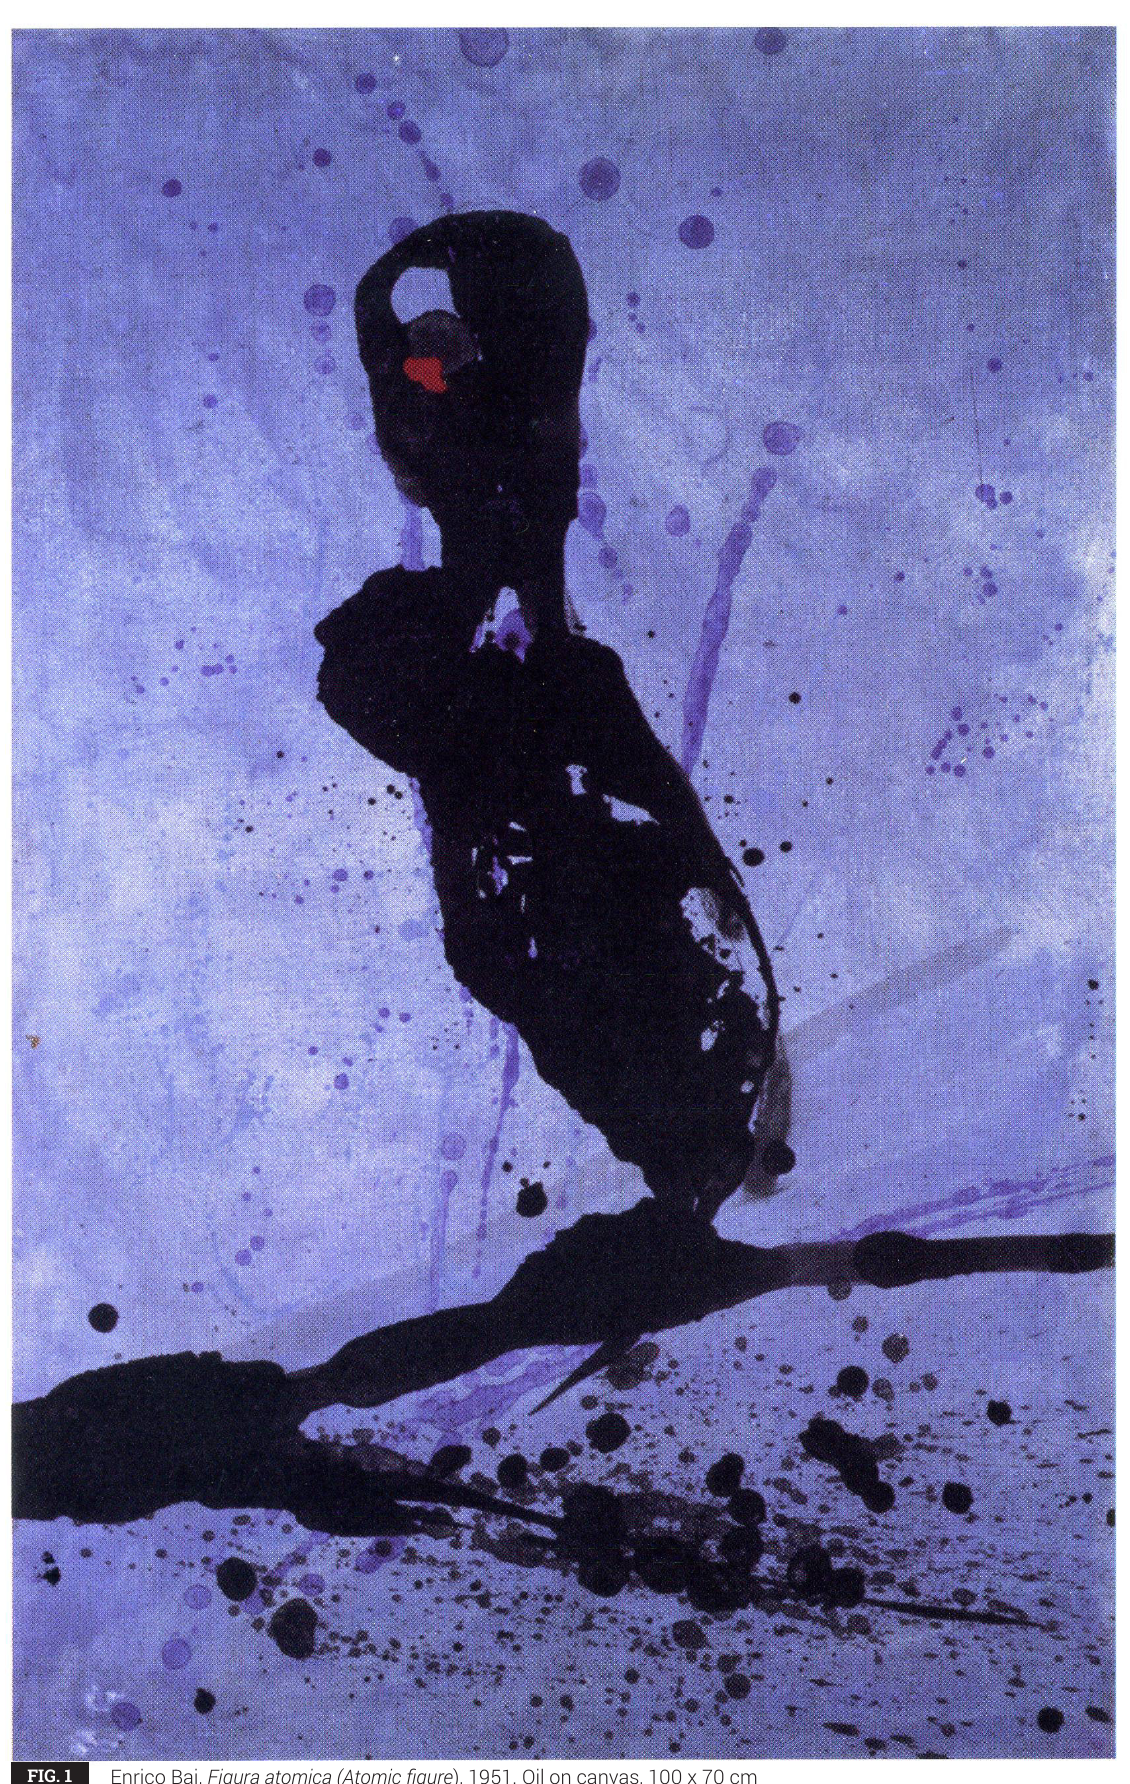
FIG. Enrico Baj, Figura atomica (Atomic figure ), 1951. Oil on canvas, 100 x 70 cm Private collection